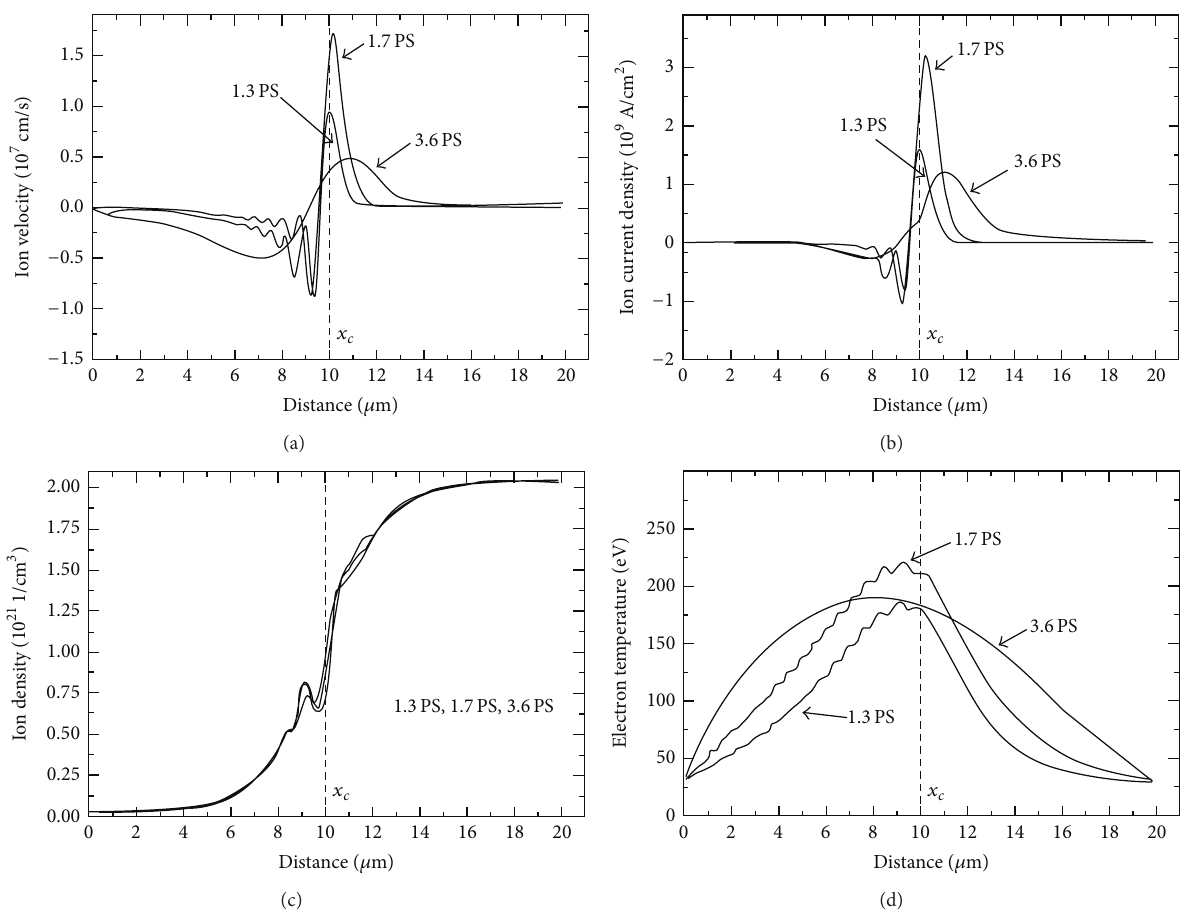
Figure 4: Spatial distributions of the ion velocity (a), the ion current density (b), the ion density (c), and the electron temperature (d) of plasma for various times measured from the beginning of the laser-plasma interaction. 𝜏 𝐿 = 1 PS, 𝐼 𝐿 = 10 16 W/cm 2 , 𝐿 𝑛 /𝜆 = 2.5